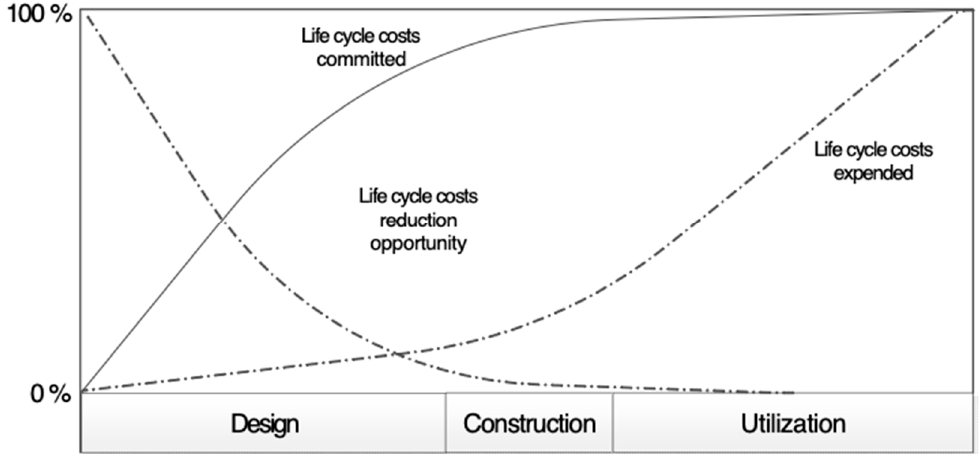
Figure 1. The general behavior of a commitment to life cycle costs [30–35].